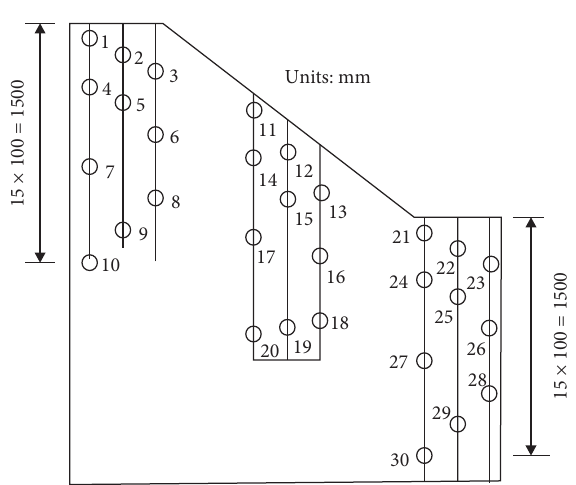
Figure 2: Sensor embedding